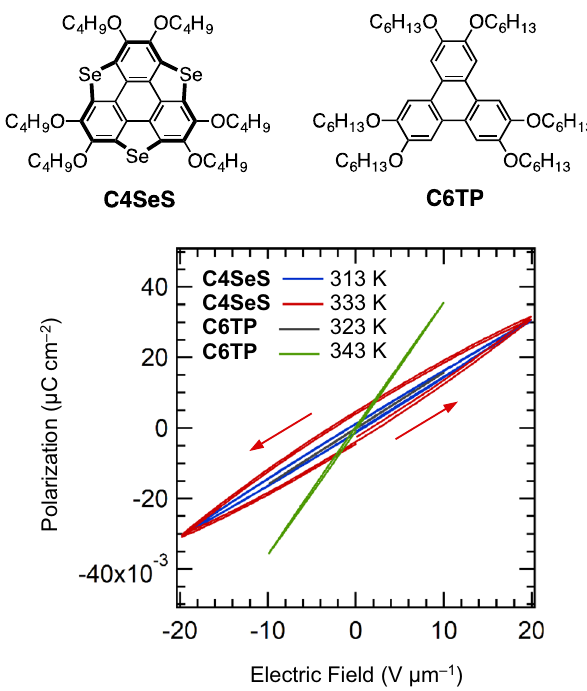
Fig. 7 Molecular structures of C4SeS and C6TP (top) and T -dependent P – E hysteresis curves at f = 100 Hz